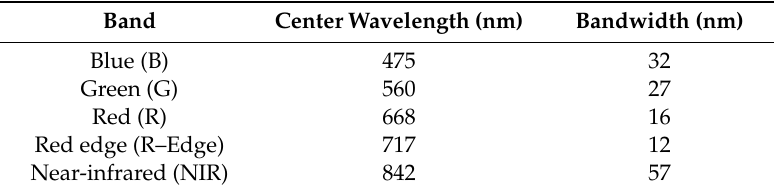
Table 2. MicaSense RedEdge spectral bands with respective wavelength and bandwidth